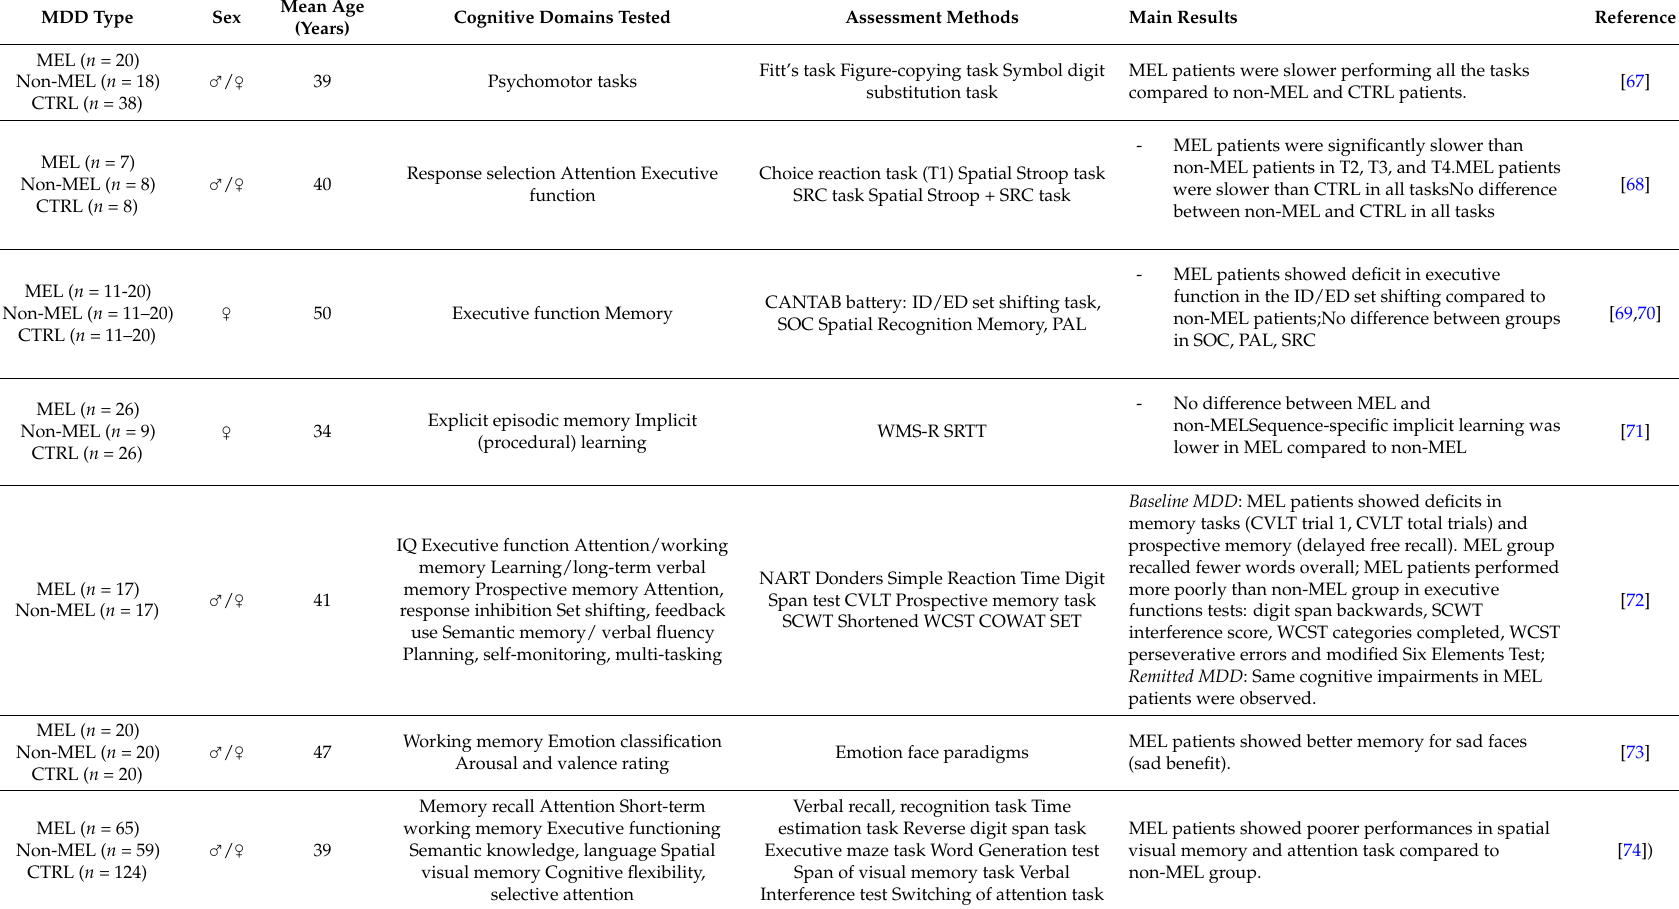
Table 1. Differential cognitive impairments in melancholic and non-melancholic patients.